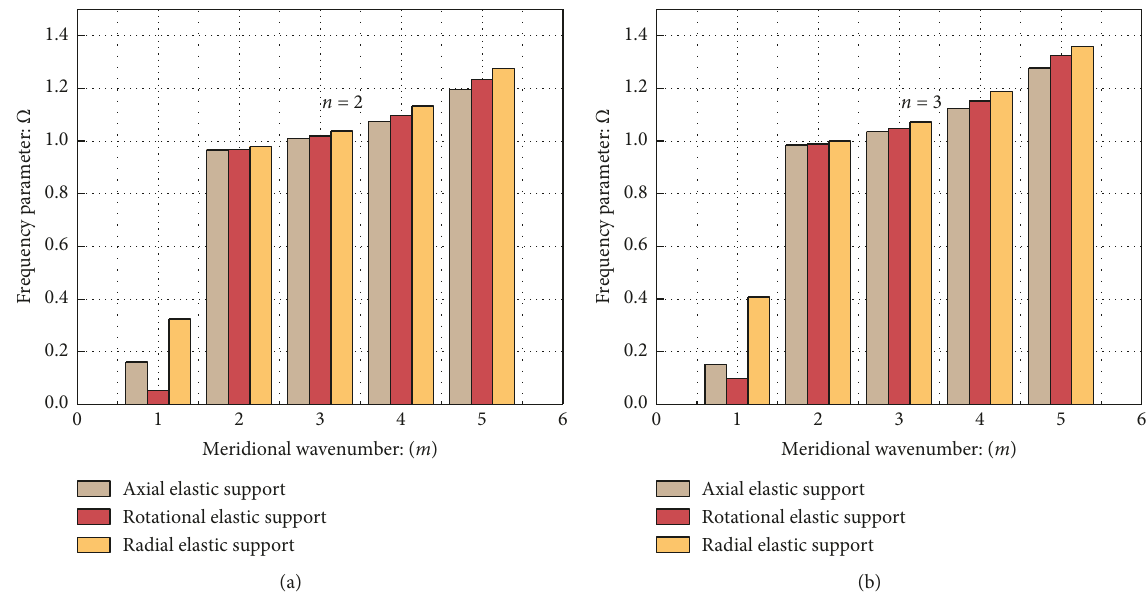
Figure 9: Nondimensional frequency Ω of uniform spherical cap with various elastic support edge